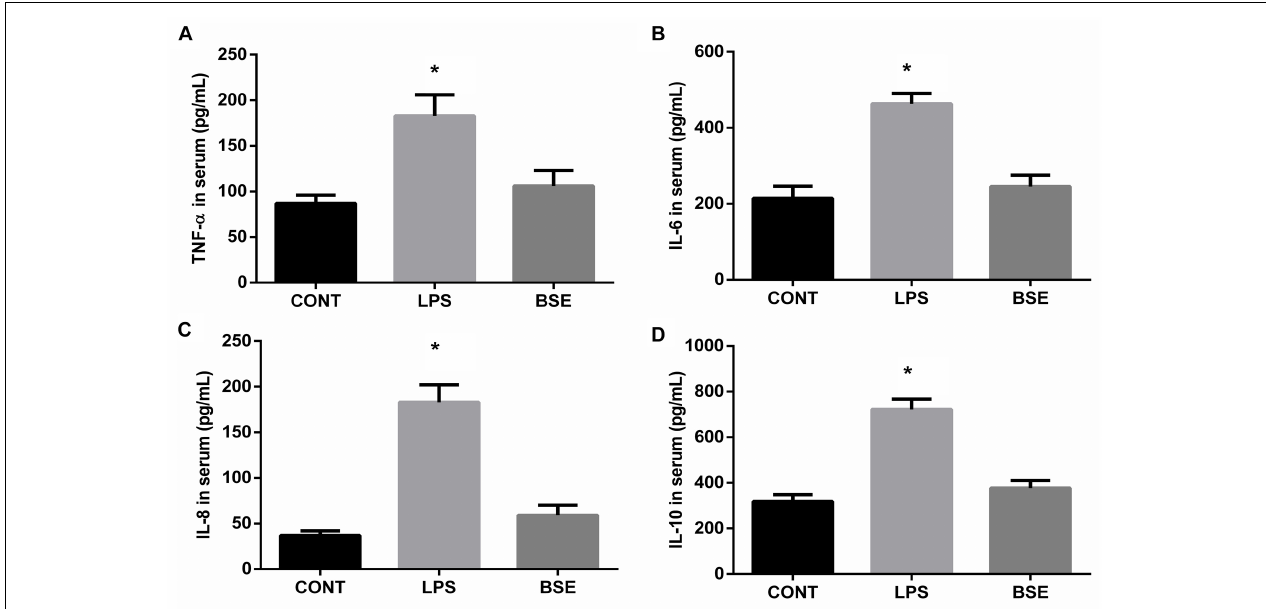
FIGURE 1 | Effects of Blidingia sp. extract on serum inflammatory cytokines content in lipopolysaccharide-challenged mice. (A) TNF- α content; (B) IL-6 content; (C) IL-8 content; (D) IL-10 content. CONT, mice gavaged with sterile saline; LPS, mice injected with lipopolysaccharide; and BSE, mice gavaged with Blidingia sp. extract and injected with lipopolysaccharide. Values are expressed as mean ± SEM, n = 8; ∗ p <